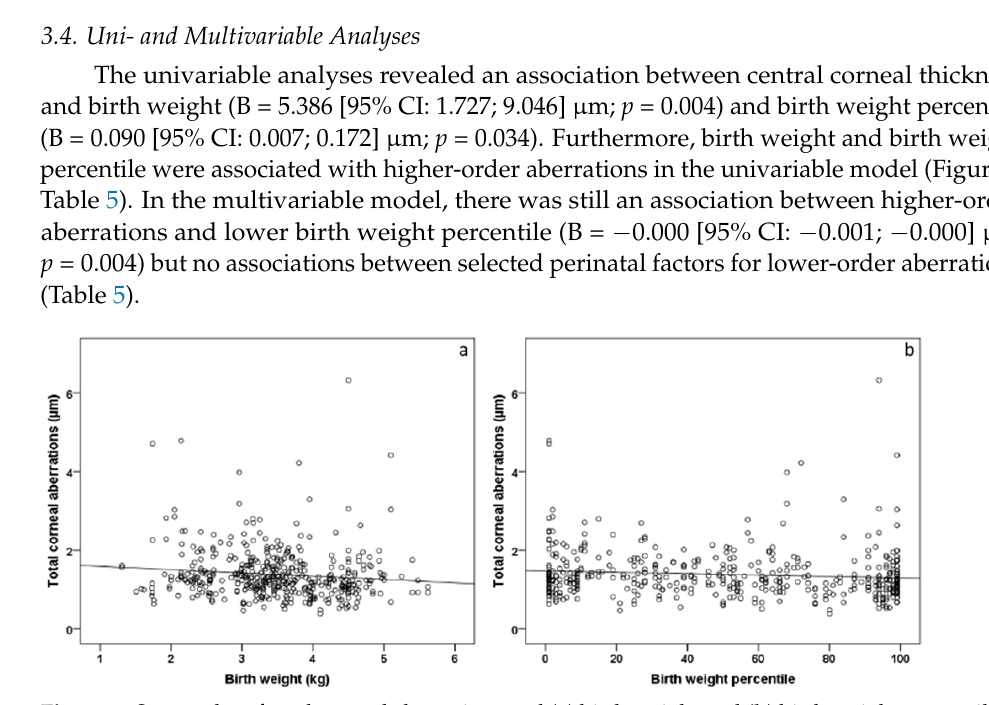
Figure 1. Scatterplot of total corneal aberrations and ( a ) birth weight and ( b ) birth weight percentile in individuals born at term ( n = 261). Participants with a lower birth weight and birth weight percentile showed increased corneal aberrations.